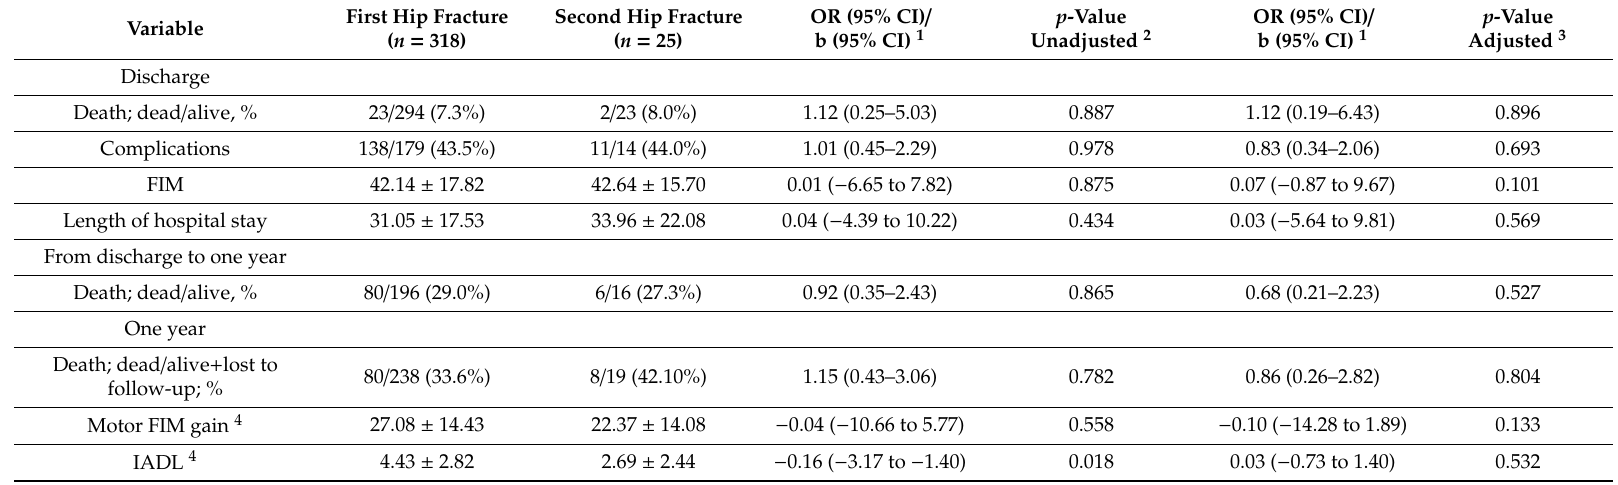
Table 2. Outcomes up to one year and second hip fracture as theirs